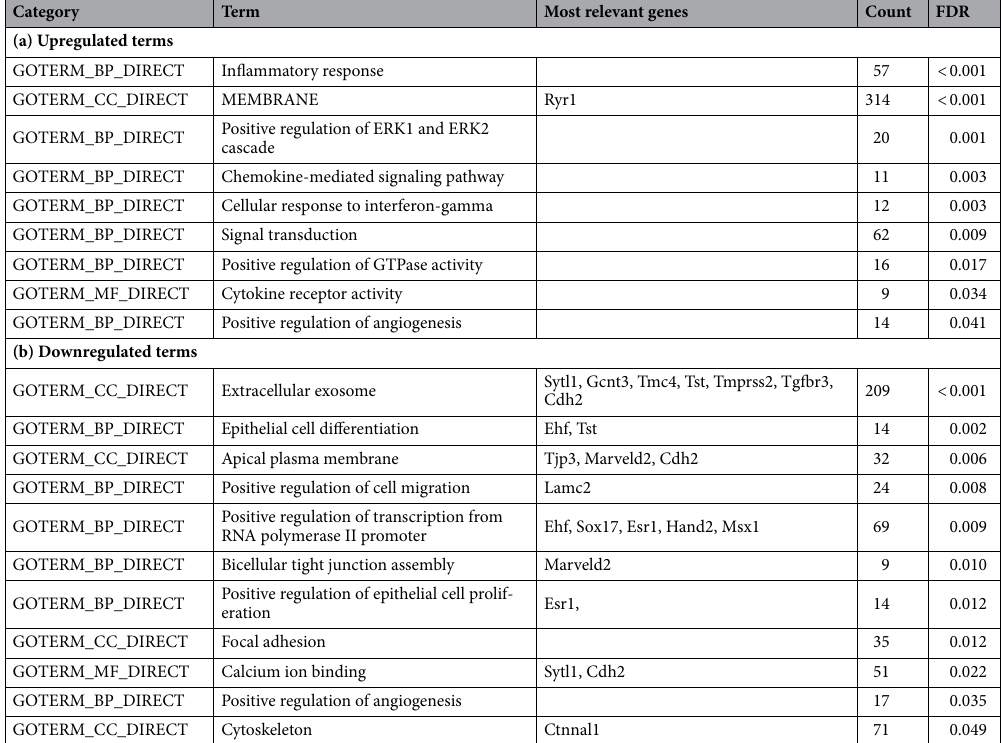
Table 1. Upregulated and downregulated terms between the tumor mass derived from the LH-R-frt-200 mouse and the healthy TG-LH-R-frt mouse. Terms most significantly upregulated (a) and downregulated (b) between the tumor mass derived from the LH-R-frt-200 mouse and the healthy TG-LH-R-frt-200